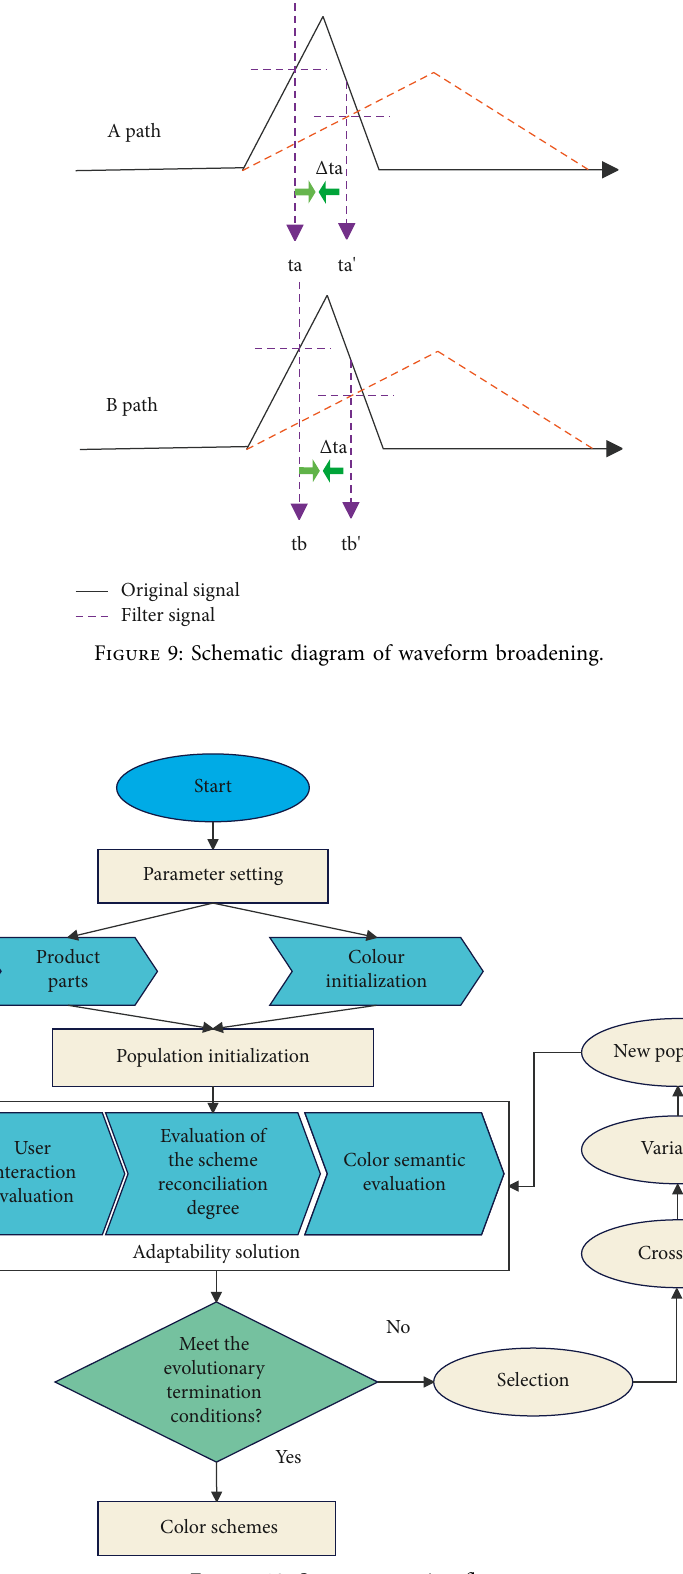
Figure 10: System operation